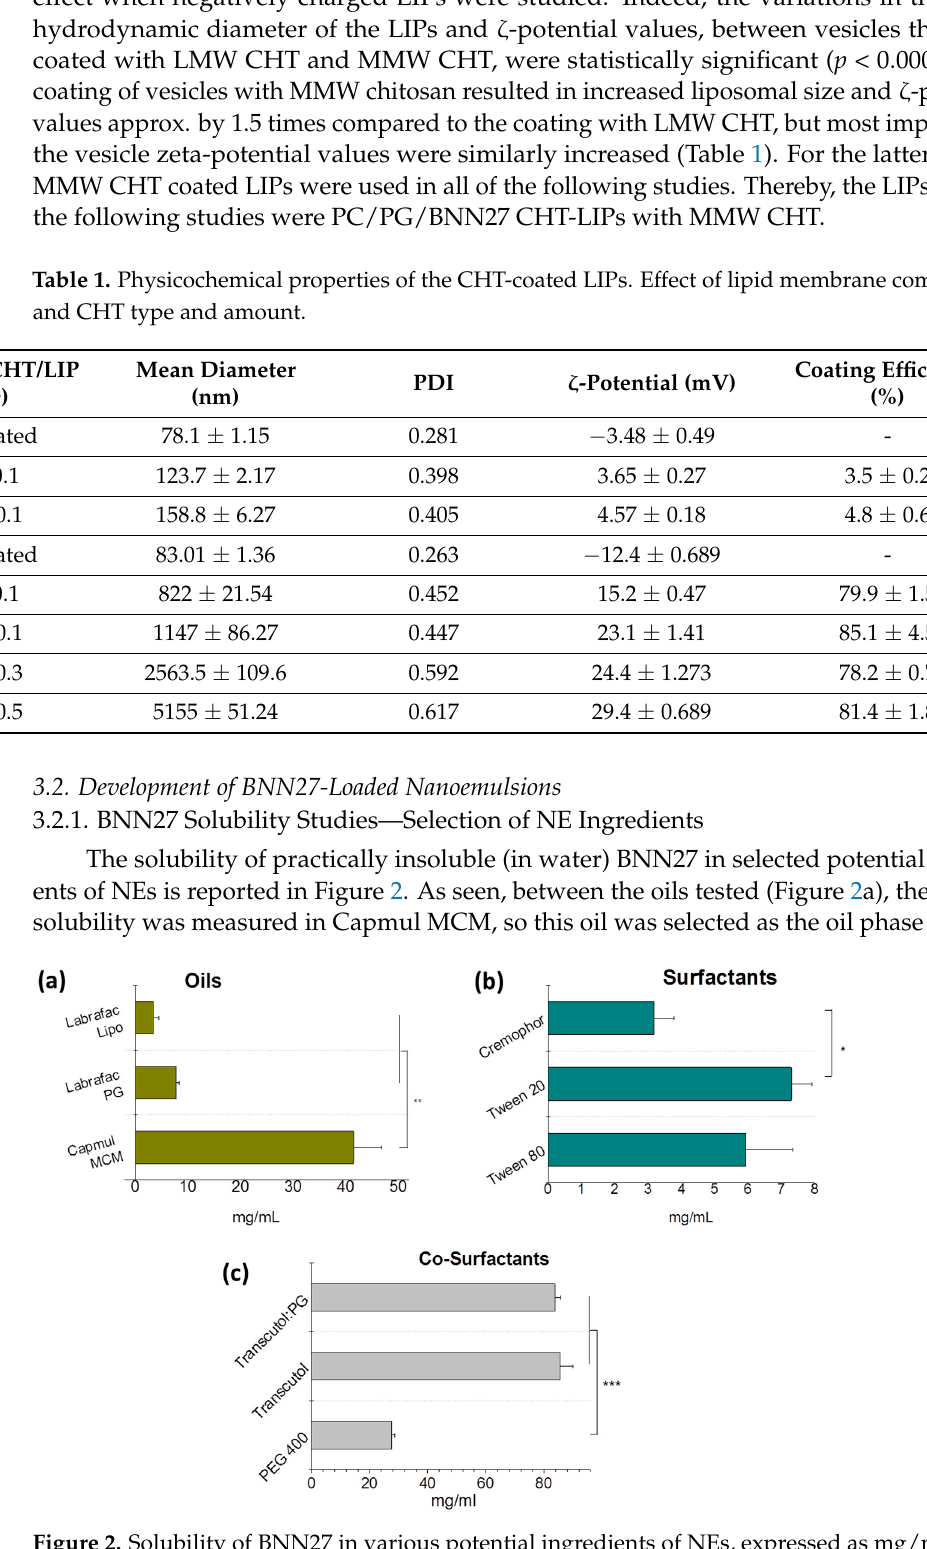
Figure 2. Solubility of BNN27 in various potential ingredients of NEs, expressed as mg/mL. Each value is the mean of at least three independent samples. ( a ) Solubility in oils. ( b ) Solubility in sur- factants. ( c ) Solubility in co-surfactants. *: p ≤ 0.05; **: p ≤ 0.01; ***: p ≤ 0.001.